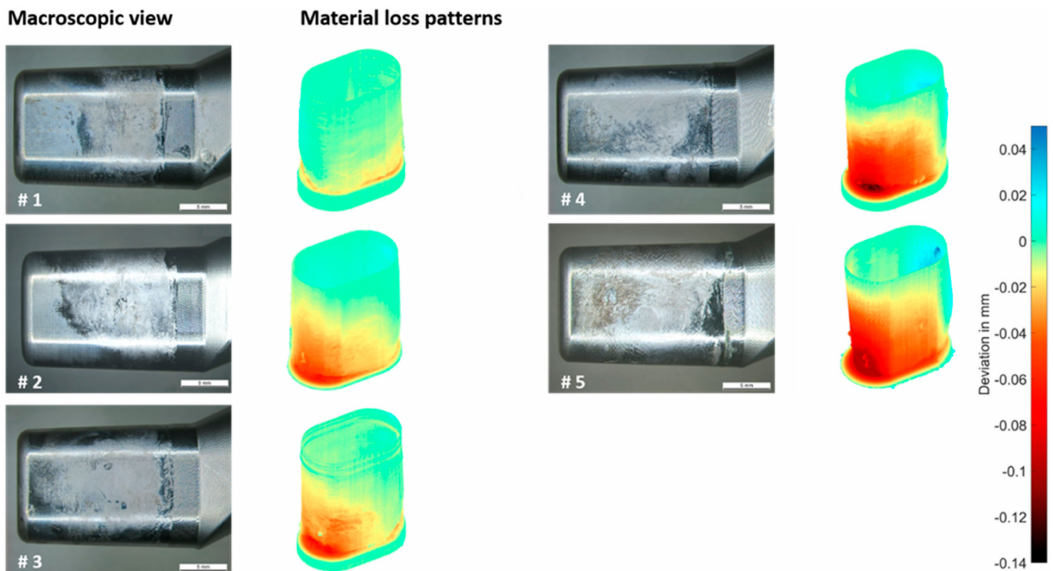
Figure 2. Macroscopic view (left) and volumetric material loss (right) of 5 symptomatic CoCr dual taper neck adapter retrieved after 61–128 months in vivo. The absence of oxygen in the energy dispersive X-ray measurements on characteristic taper surface points indicated that electrochemical processes due to contact, crevice and fretting corrosion a ff ected the ability of the CoCr alloy to form a passive oxide layer in the physiological environment, resulting in increased material loss and metal ion